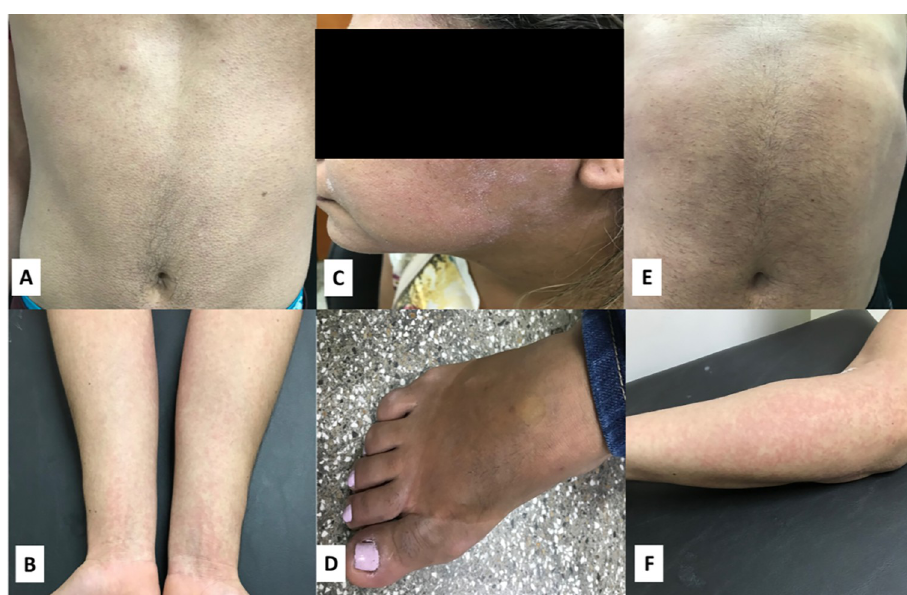
Fig 2. Rash observed in patients with diagnosis for arboviruses. (A and B) rash observed on thorax and upper limbs of ZIKV-positive patient. (C and D) peeling rash on face and lower limb edema of a CHIKV-positive patient. (E and F) rash observed on thorax, abdomen and upper limbs of a dengue-positive patient.